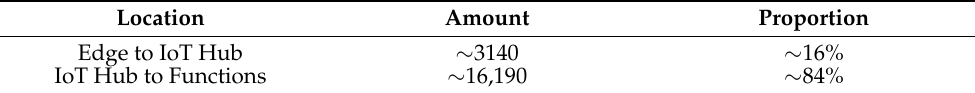
Table 2. A summary of location, amount, and proportion of lost data